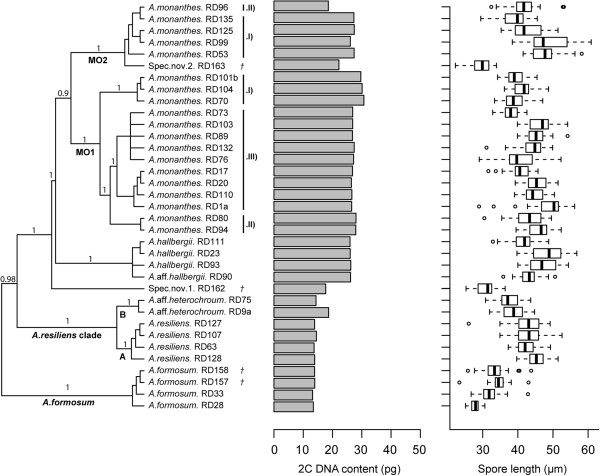
Phylogenetic framework (based on Bayesian analysis) of the plastid genome, as presented in Dyer et al. [29], of the Asplenium monanthes complex and related lineages, together with nuclear DNA content and spore length for each specimen analysed. Tree is rooted according to [29]. Posterior branch support (≥0.8) is shown. 2C DNA content for each specimen is represented by a bar chart, whilst spore length data are shown as box plots. Each boxplot represents the variance of measurements of spores within each specimen, the thick horizontal line is the median, the box indicates the variation observed between the 25th and 75th percentiles, the whiskers show the variance range, and small circles identify extreme outliers. MO1 and MO2 indicate the two distinct A.monanthes clades and these are further divided into sub-clades I and II, and also III in the case of MO1 only. † symbols indicate samples for which 2C DNA content measurements were made from 6 month old silica material.